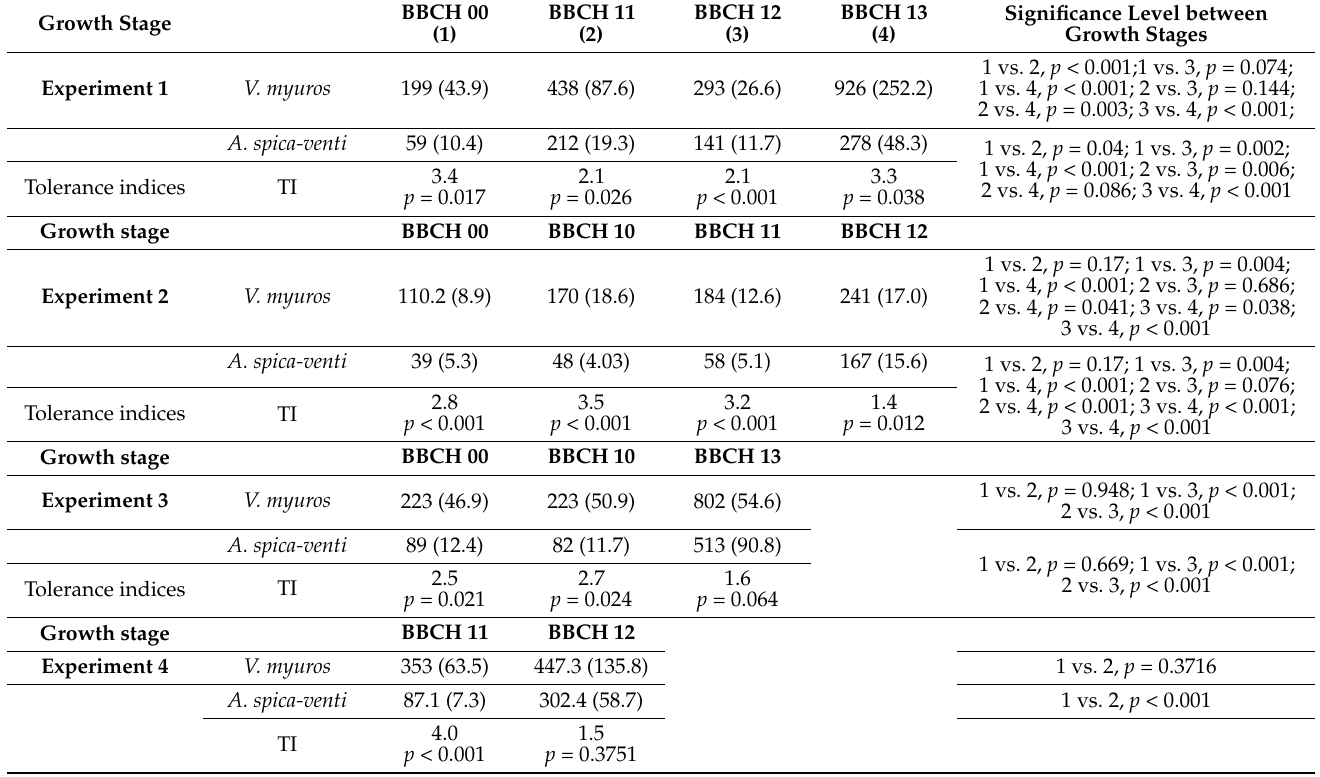
Figure 4. Prosulfocarb dose–response on aboveground fresh weight represented as percentage of untreated control of Vulpia myuros and Apera spica-venti Experiment 4 at: BBCH 11 ( A ); and BBCH 12 ( B ). Table 2. Prosulfocarb doses (g ha − 1 ) providing 50% reduction in fresh weight of V. myuros and A. spica-venti estimated using log-logistic model. Standard errors are presented in